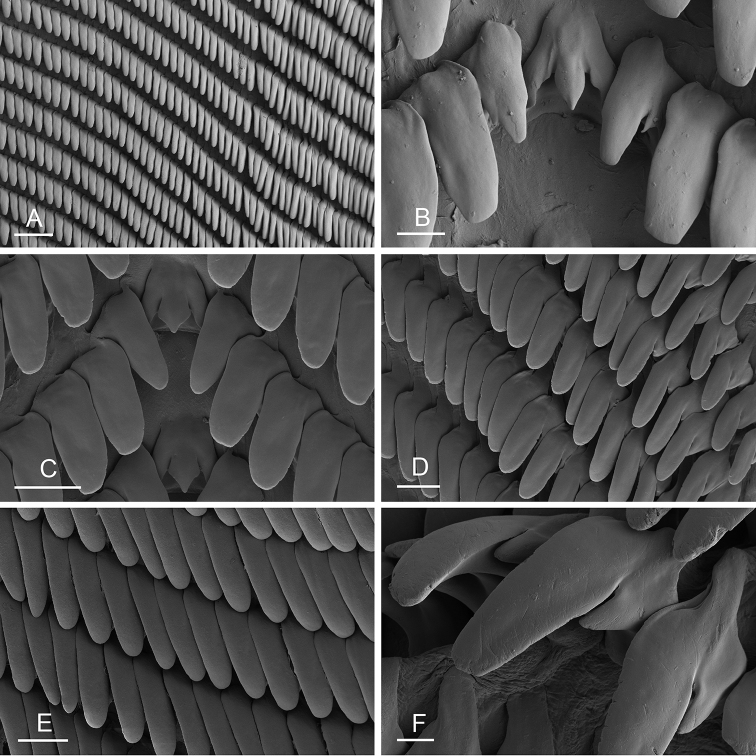
Radula, Peronia
sydneyensisA, B Australia, Queensland C–F New Caledonia A lateral teeth, [2680] (MTQ) B rachidian and innermost lateral teeth, [2680] (MTQ) C rachidian and innermost lateral teeth, [6189] (MNHN-IM-2019-1594) D lateral and outermost lateral teeth, [6189] (MNHN-IM-2019-1594) E lateral teeth, [6195] (MNHN-IM-2019-1595) F lateral teeth, [6220] (MNHN-IM-2019-1598). Scale bars: 100 μm (A), 20 μm (B–D), 40 μm (E), 10 μm (F).